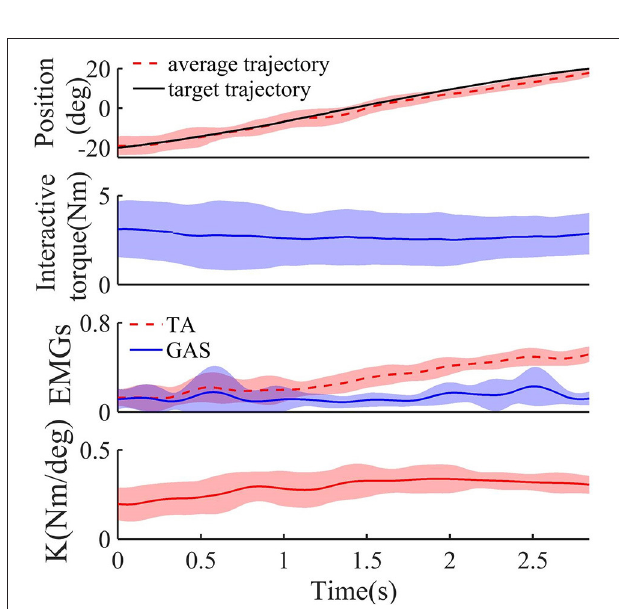
FIGURE 6 | The target, average tracking trajectory, average interaction torque, average processed EMG signals from TA and GAS, and average K -value of all subject during dorsiflexion phase when robot was controlled by AACS ( n trials). Solid or dotted line, average curves; shaded area, standard